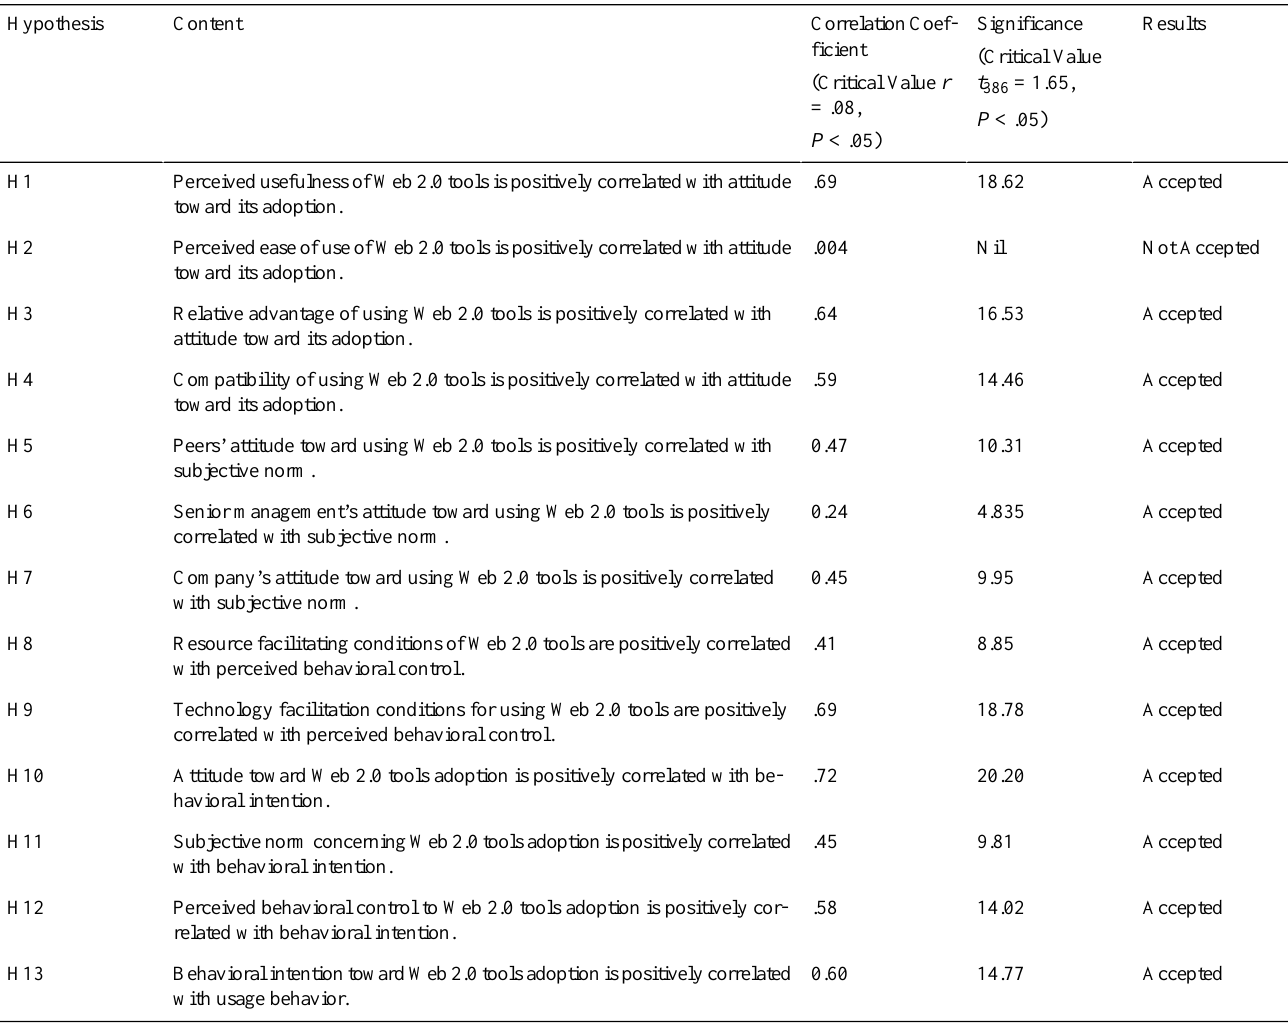
Table 4. Hypothesis testing